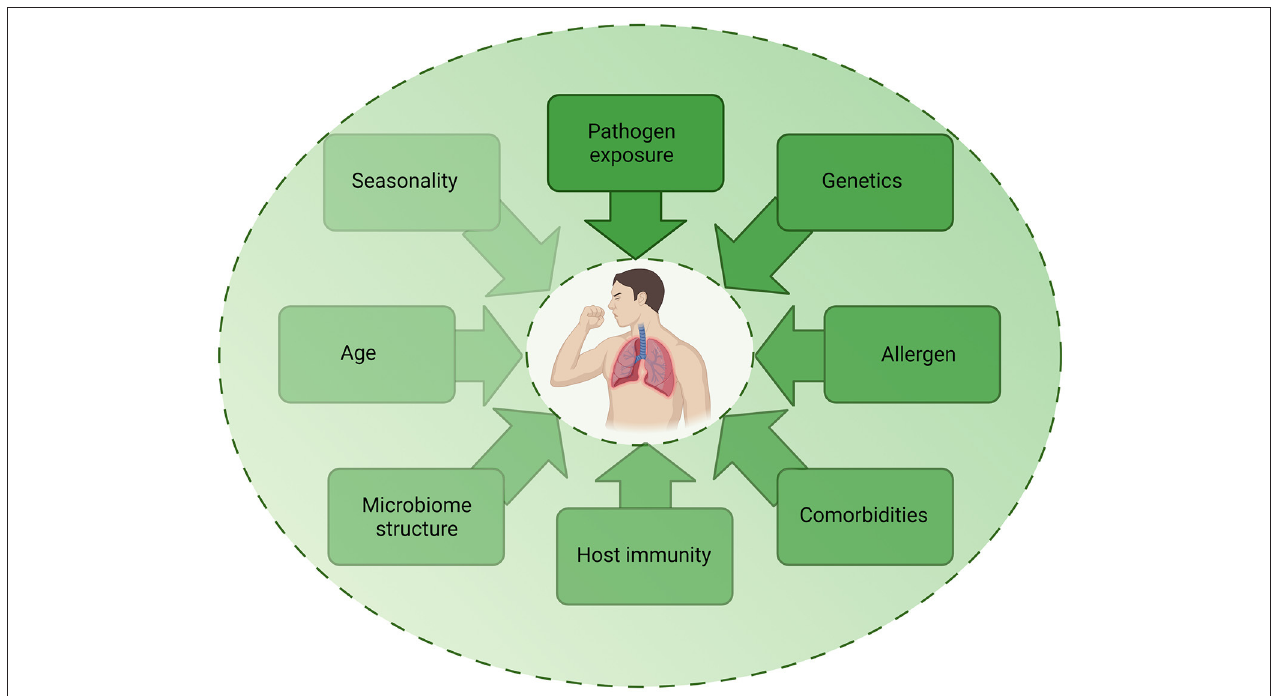
FIGURE 3 | Factors contributing to infection-induced exacerbations. The role of infection in exacerbations are likely to be multifactorial, with several host, pathogen, and environmental factors impacting on the contribution of infection to an exacerbation. Each factor may be multi-directional and directly or indirectly impact on another factor, highlighting the complex mechanisms involved in exacerbations. Created using